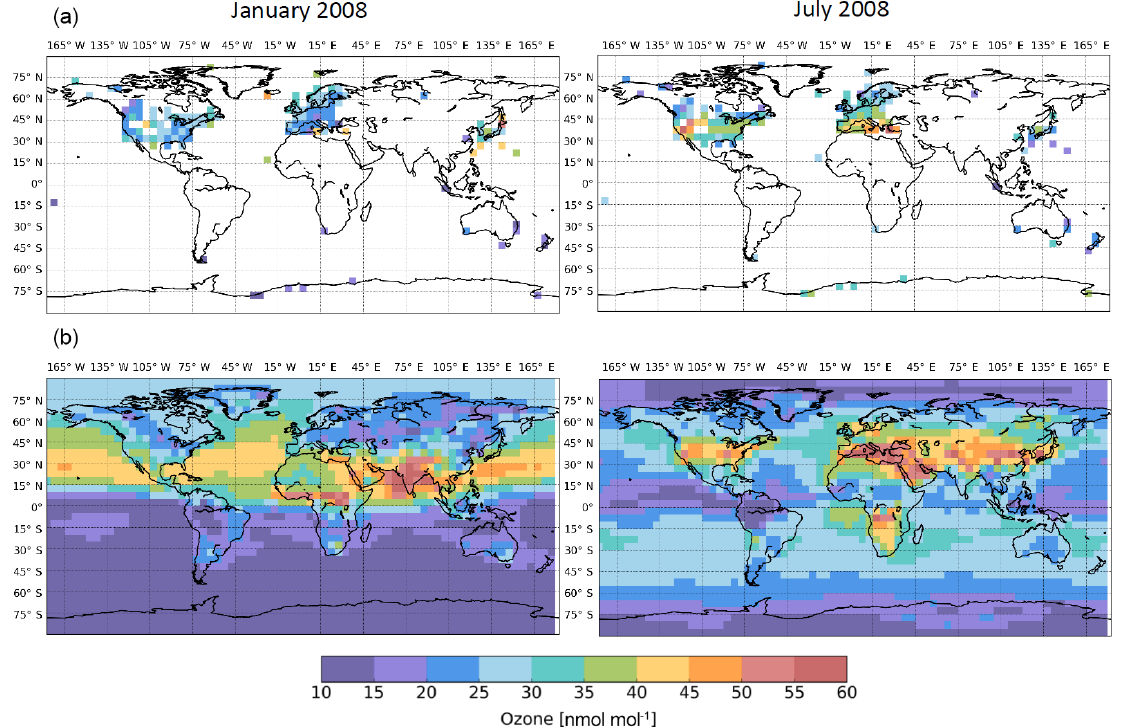
Figure 8. Comparison of gridded rural surface ozone observations from the TOAR database (Schultz et al., 2017) (a) with ECHAM- HAMMOZ output (b) for January and July 2008. The model results have been regridded to 5 ◦ × 5 ◦ to match the resolution of the ob- servations.